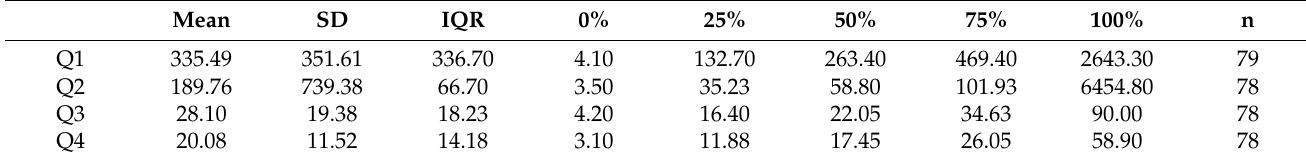
Table 5. Density (Inhabitants/Km 2 ). Sources: own elaboration based on data from the Galician Institute of Statistics IGE, Municipal Register of Inhabitants, the year 2021.